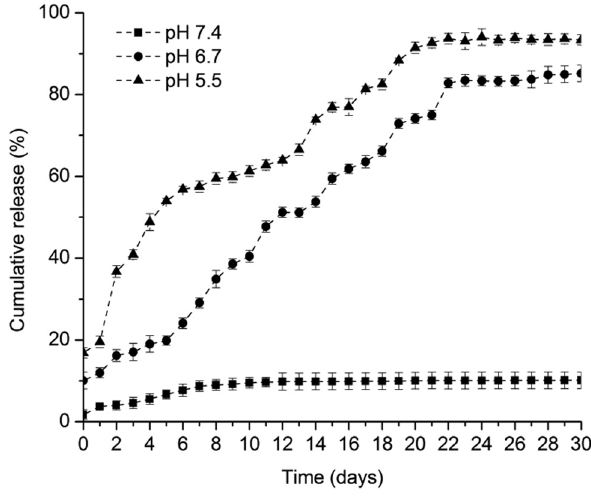
Figure 8: MTX release in PBS at pH 5.5, 6.7, and 7.4 for 30 days.